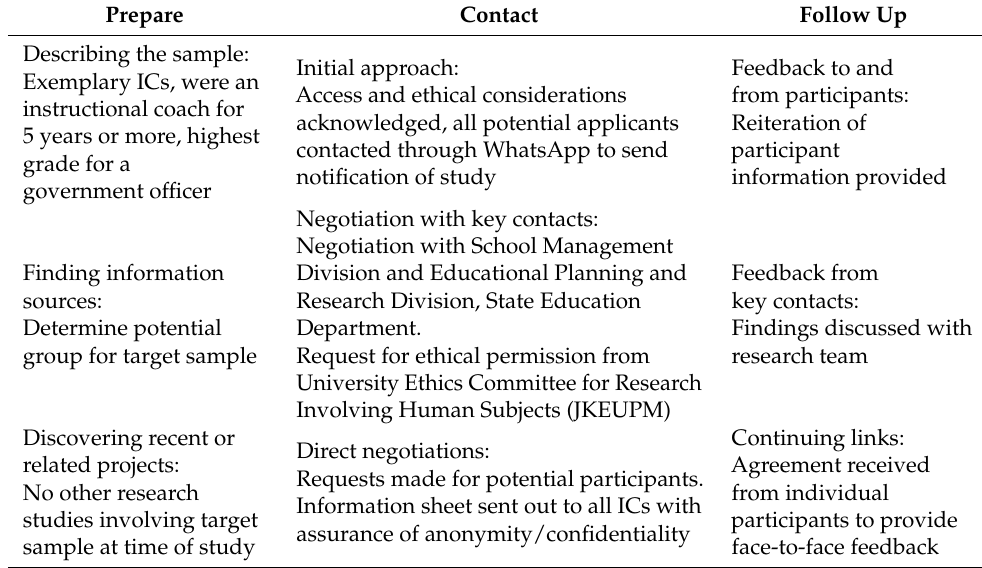
Table 2. Sampling and recruitment